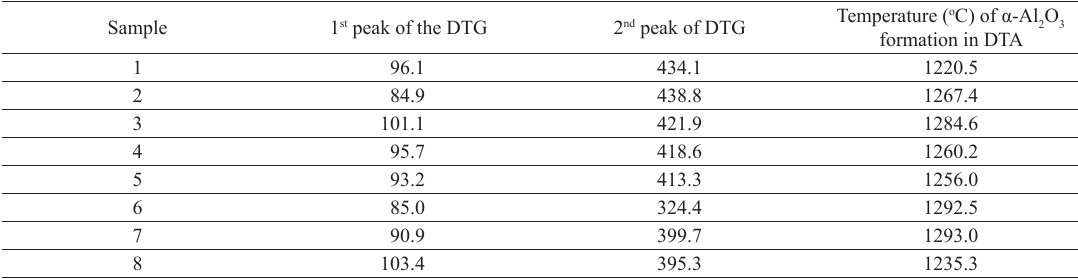
Table 3. DTA and TG results.